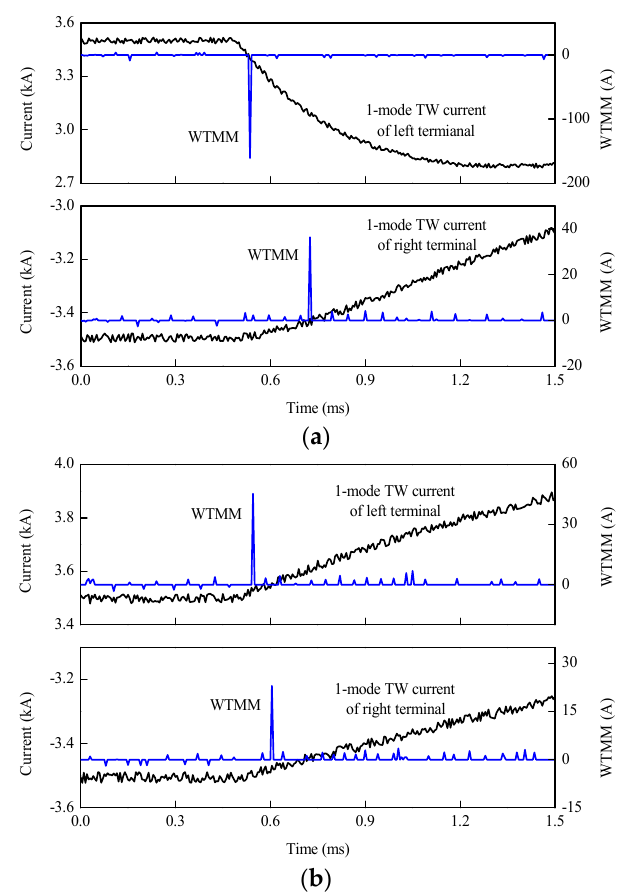
Figure 18. Fault section identification under noise disturbance: ( a ) Noise disturbance for the external fault; ( b ) Noise disturbance for the internal fault.